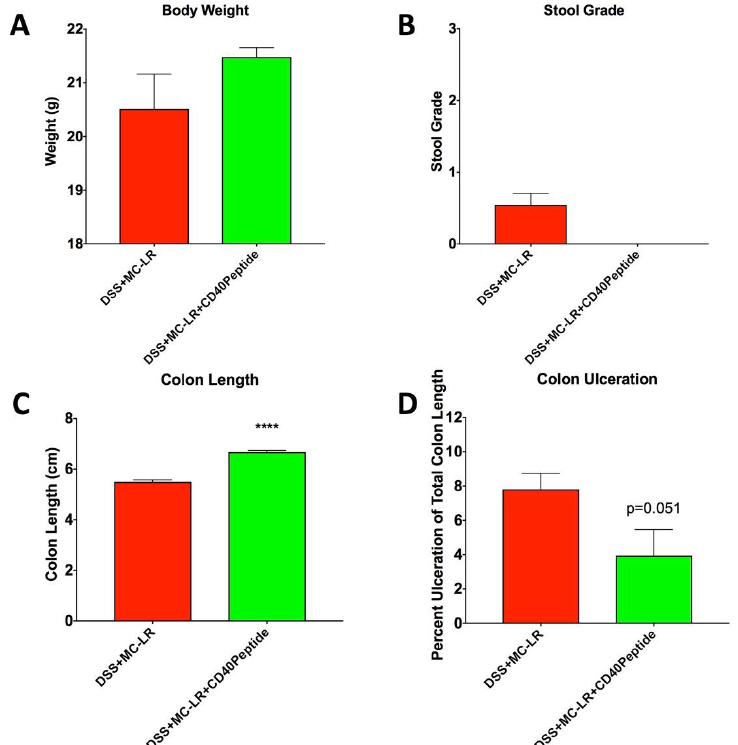
Figure 8. CD40 blocking peptide treatment in mice with pre-existing colitis and MC-LR exposure. (A) Body weight. Endpoint bodyweight of mice with DSS + MC-LR + CD40 peptide exposure was greater, although not significantly, than mice with DSS + MC-LR exposure with CD40 peptide treatment, showing a trend in bodyweight recovery with CD40 peptide treatment. (B) Stool grade. At the endpoint of the study, mice that received DSS + MC-LR exposure had blood that persisted in their stool. However, with CD40 treatment on top of DSS + MC-LR exposure, mice had full recovery in their stool, with no blood present. (C) Colon length. Colon length was significantly longer with CD40 peptide treatment versus without treatment in mice given DSS + MC-LR exposure. (D) Colon ulceration. Percent ulceration of total colon length was decreased with CD40 peptide treatment than without treatment in mice given DSS + MC-LR exposure. Data presented indicate the mean ± SEM ( n = 4–11 mice per group). **** p < 0.0001.